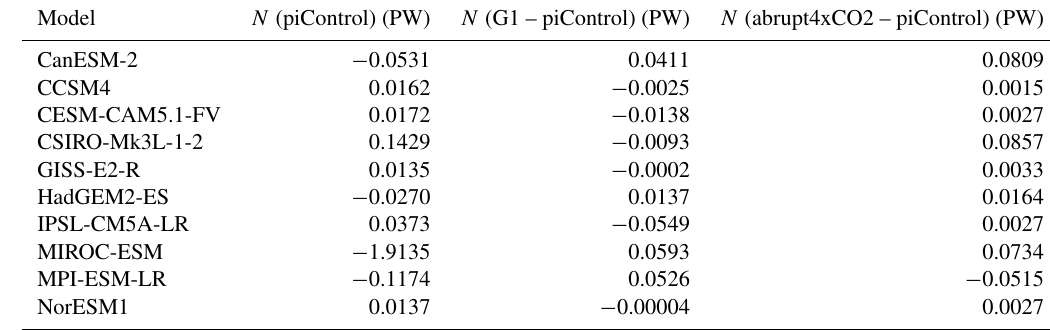
Table A1. Northward energy transport residual error at the North Pole in different models and runs, to four decimal places. Model N (piControl) (PW) N (abrupt4xCO2 – piControl) (PW) CanESM-2